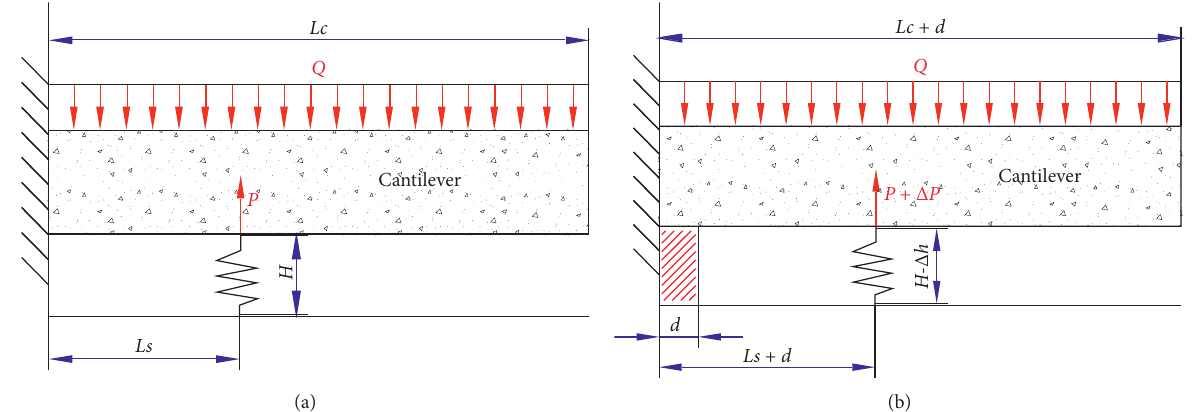
Figure 3: Shield-roof interaction model. (a) Before cutting. (b) After cutting.